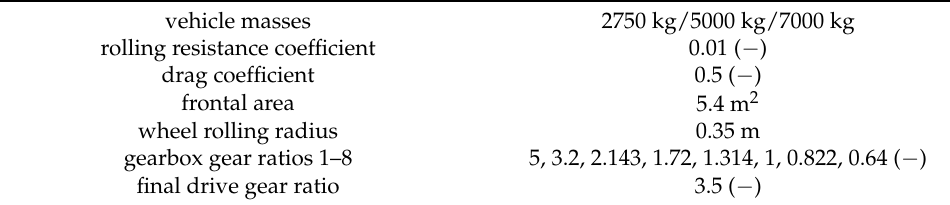
Table 5. Main vehicle